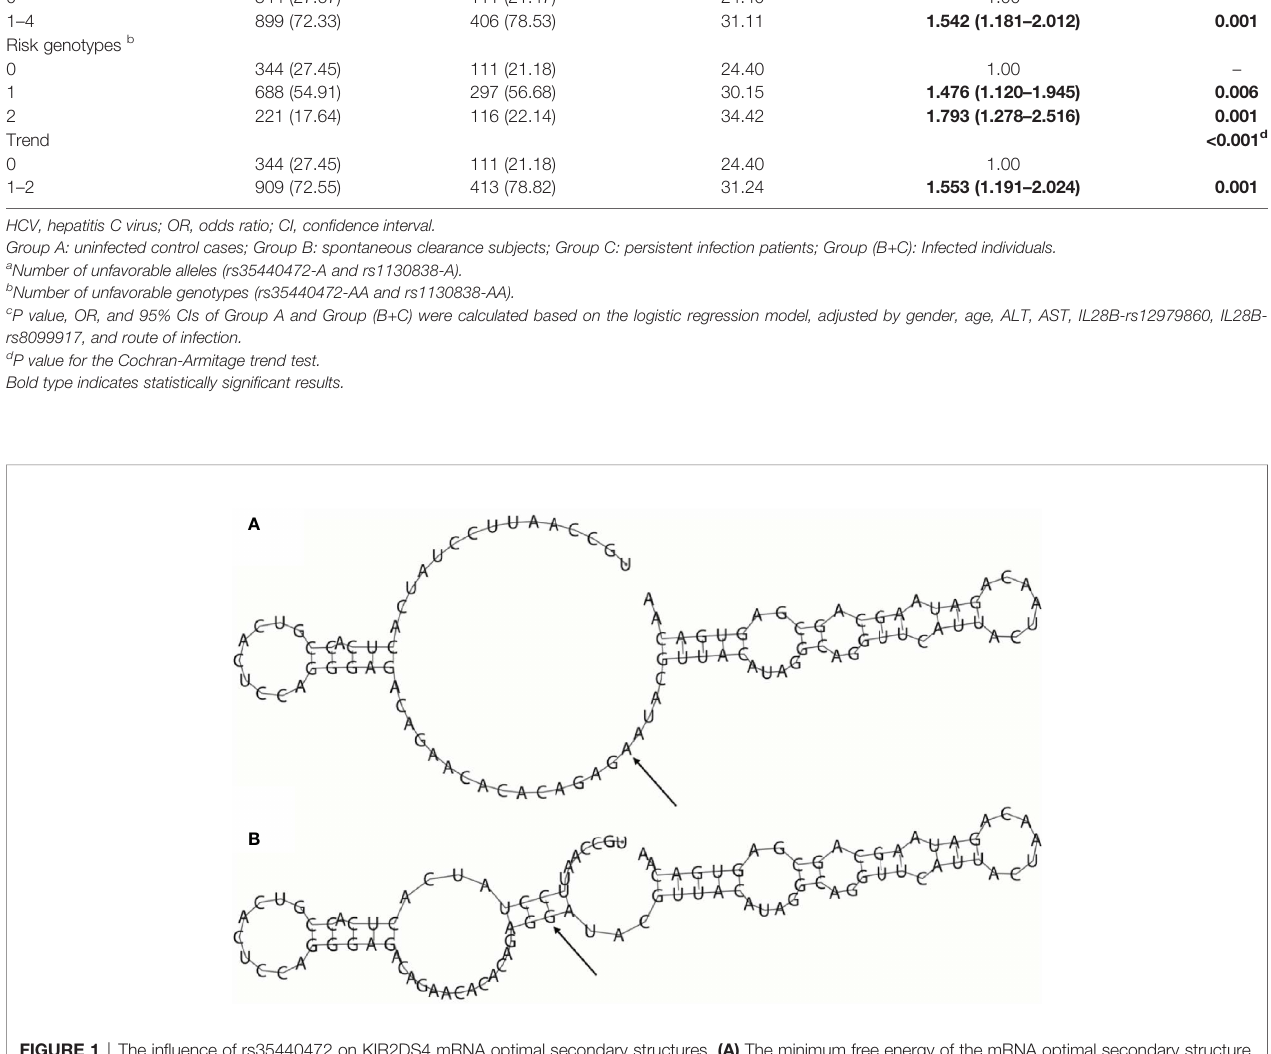
FIGURE 1 | The in fl uence of rs35440472 on KIR2DS4 mRNA optimal secondary structures. (A) The minimum free energy of the mRNA optimal secondary structure with a minimum free energy of − 10.70 kcal/mol for rs35440472-A; (B) The minimum free energy of the mRNA optimal secondary structure with a minimum free energy of − 11.70 kcal/mol for rs35440472-G. Changes in the local structure were illustrated by the RNAfold Web Server (Data available: http://rna.tbi.univie.ac.at// cgi-bin/RNAWebSuite/RNAfold.cgi). The arrow marks the position of the mutation (50 bases upstream and 50 bases downstream from the